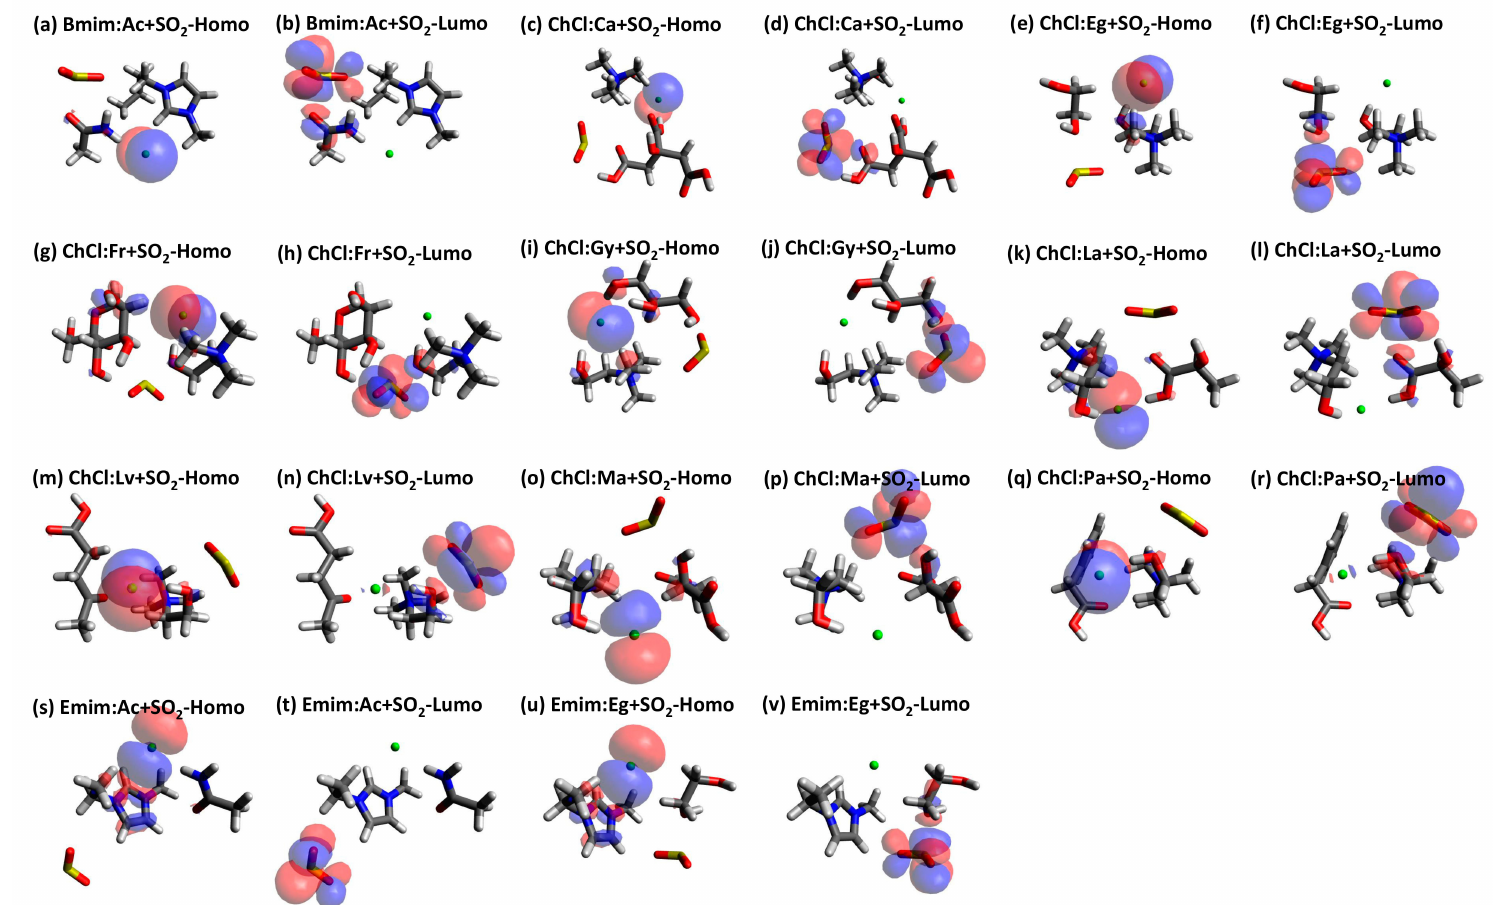
Figure 6. HOMO-LUMO graphs for each DES + SO 2 structure (positive (blue) and negative (red)